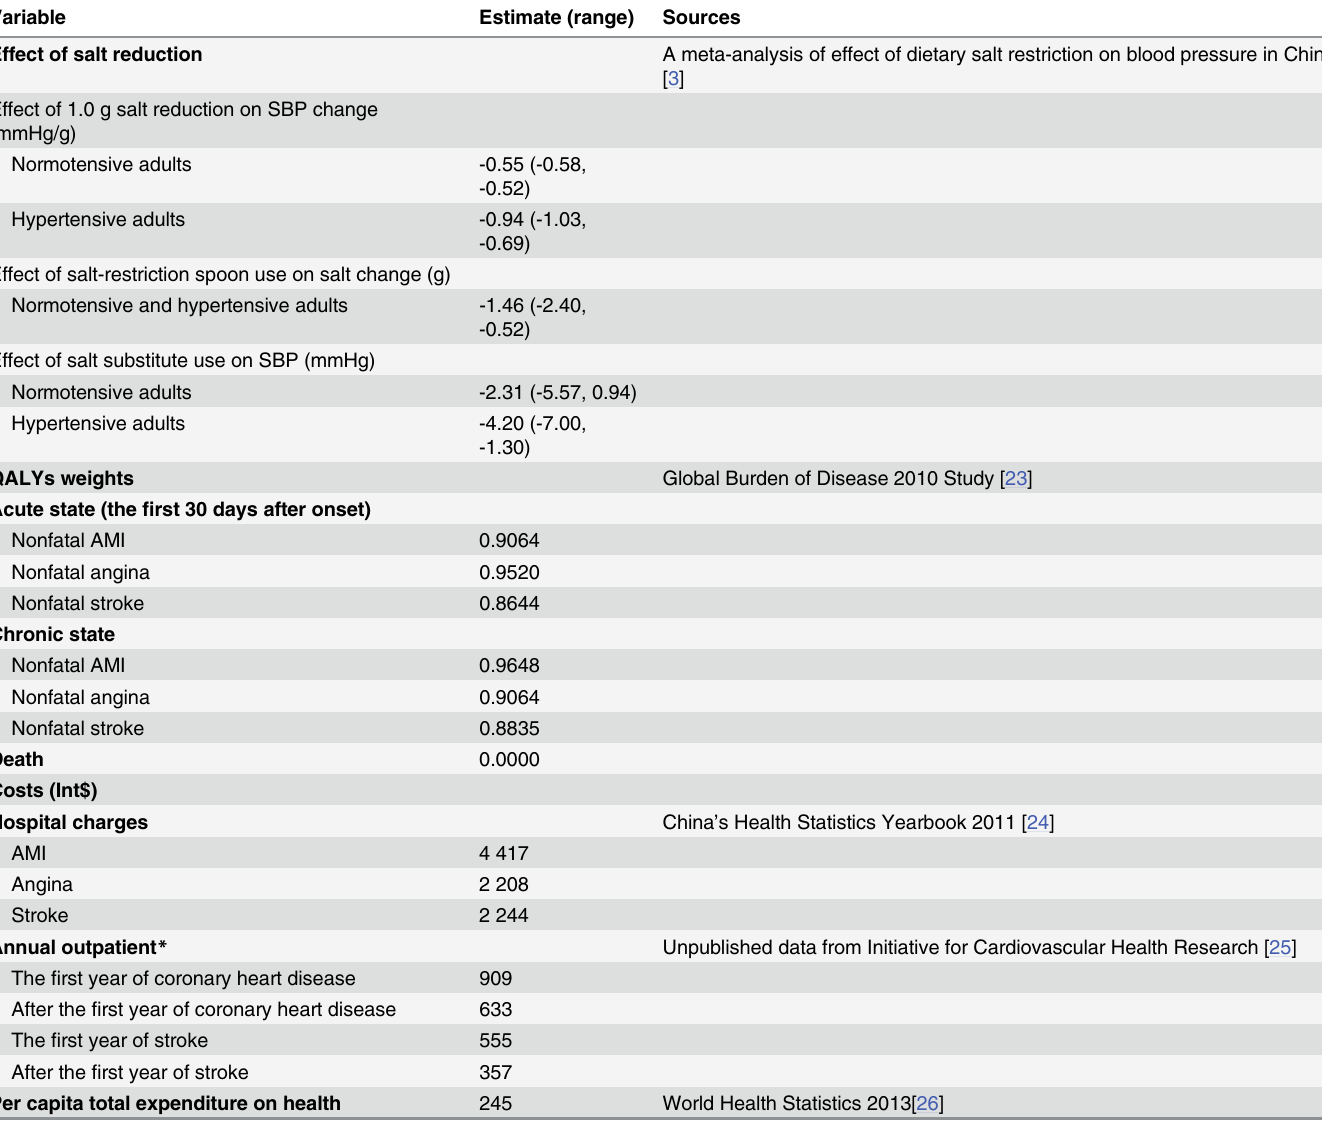
Table 2. Main assumptions for the effect of salt intervention and CVD treatment costs, the CVD Policy Model-China.